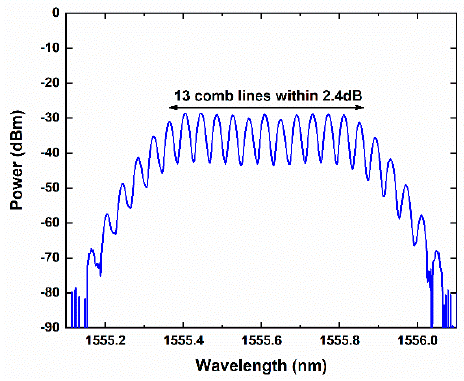
Figure 8. Optical spectrum of the generated OFC.